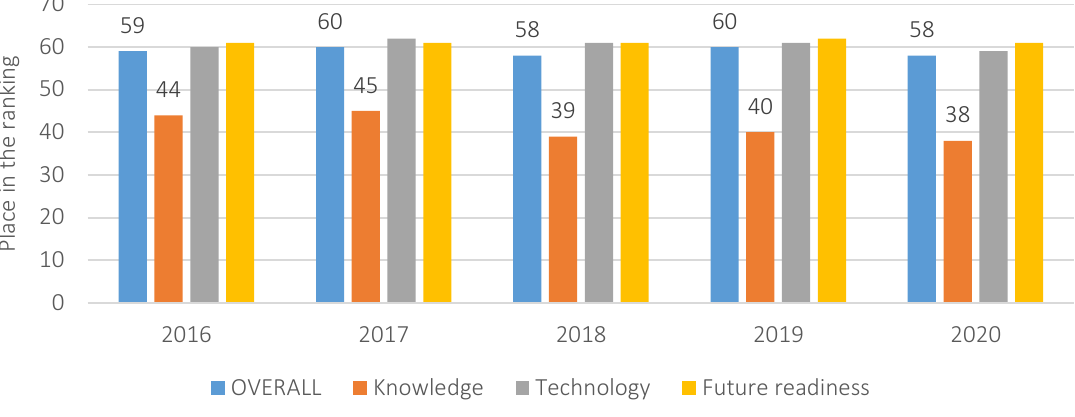
Figure 3. Dynamics of places of digital competitiveness rating components of